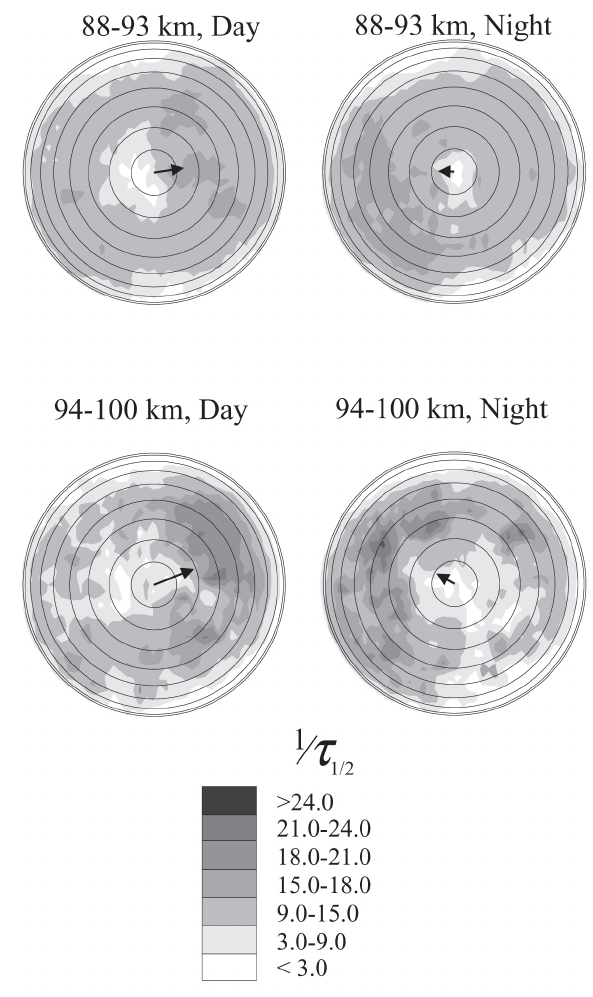
Fig. 6. Contour map of the average inverse decay times as a func- tion of zenith angle and azimuth for the Clovar radar, broken up according to daytime and nightime, for the period from June to Au- gust 1999. North is vertical, and the black circles show 10 ◦ steps in zenith angle.